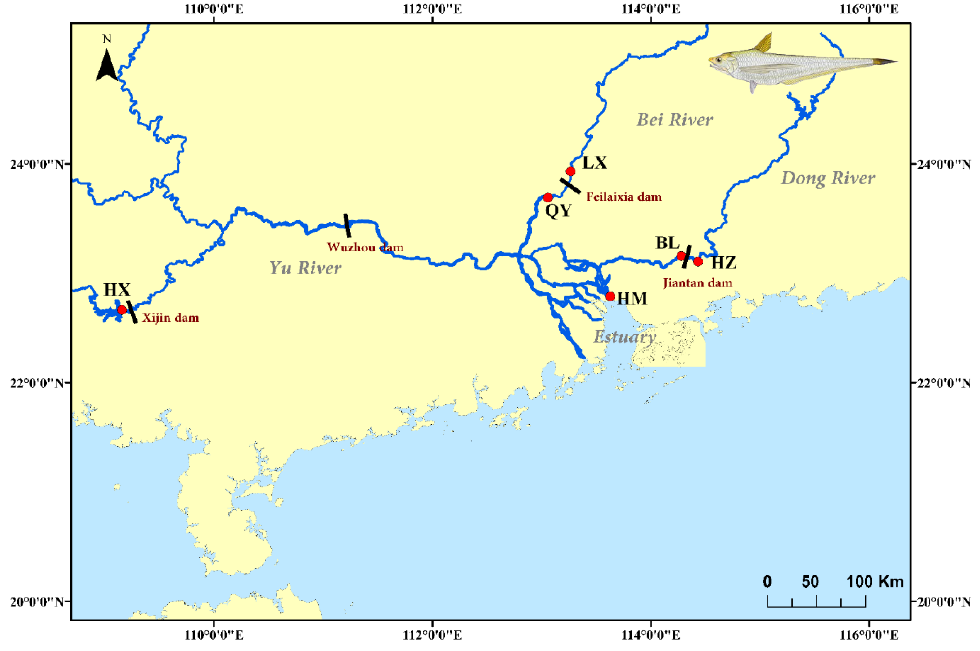
Figure 1. Map of 6 collection sites (red dots) in the three tributaries and estuary of the Pearl River, China. The HX, LX, and HZ are located upstream from dams, defined as upstream populations. Black lines represent dams.